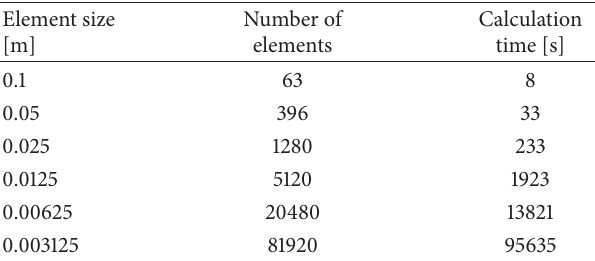
Table 4: Mesh sensitivity analysis for a blast-loaded laminated